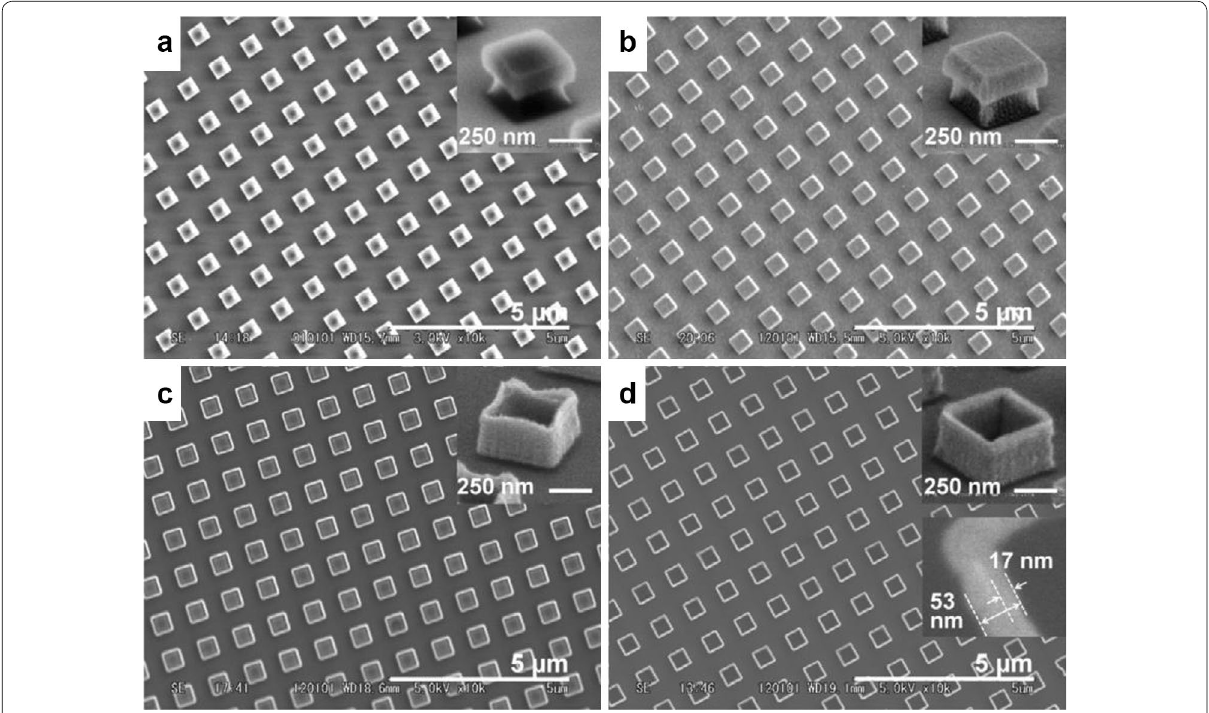
Fig. 2 SEM images after a the RIE process, b 3 min of Au deposition, c 5 min of ion milling, and d 10 min of piranha cleaning. The bilayer polymer was imprinted by UV-NIL with a 400 nm square pattern. The thicknesses of the bending zone and undercut after RIE were around 53 and 17 nm, respectively. The insets represent 60°-tilted SEM images